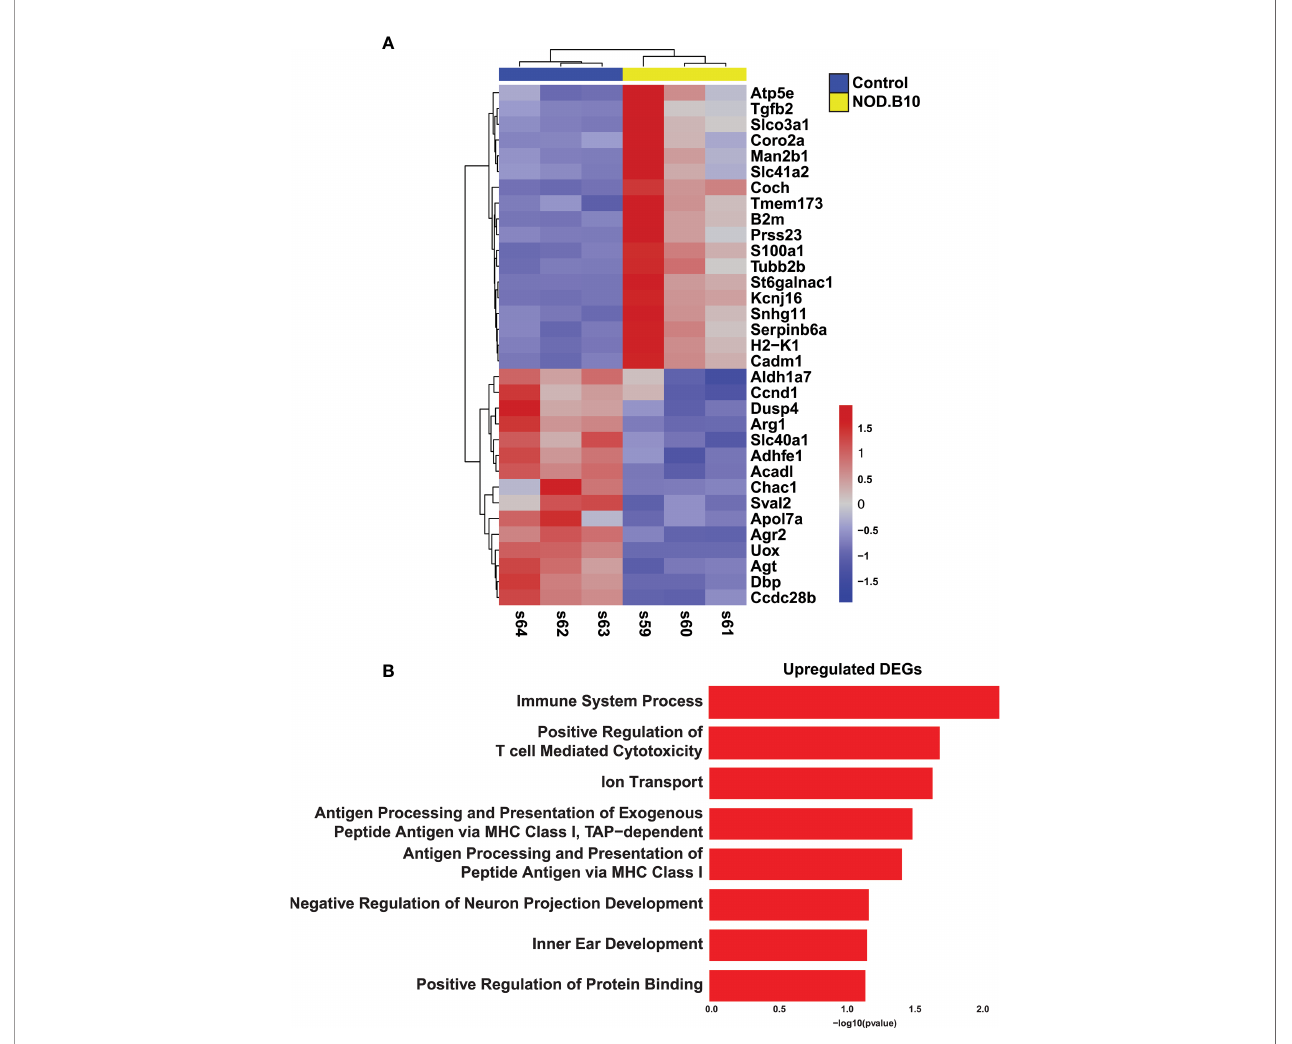
FIGURE 2 | Comparative Analysis of Sjögren ’ s Syndrome Mouse Models. (A) Heatmap visualization of the common 33 overlapping genes identi fi ed in the RNA-seq datasets described here (Horeth et al.) and the Nguyen et al. (56) microarray dataset. (B) Bar plot highlights the biological processes enriched in the common 18 upregulated genes identi fi ed in panel (A)